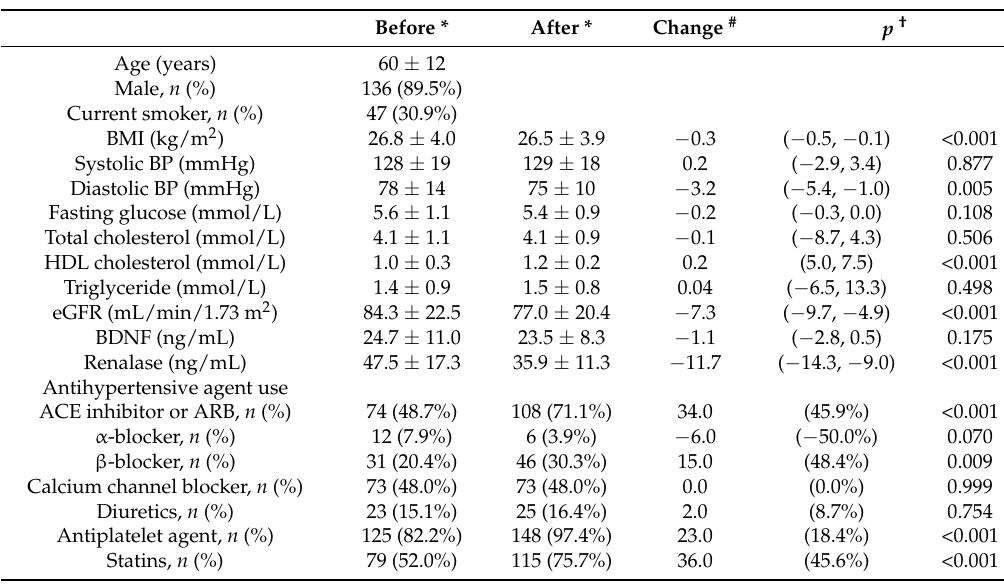
Figure 1. Flow diagram of enrollment of study subjects. Abbreviations: PCI, percutaneous coronary intervention; MI, myocardial infarction. Table 1. Clinical data of patients ( n = 152) before and after percutaneous coronary intervention (PCI).